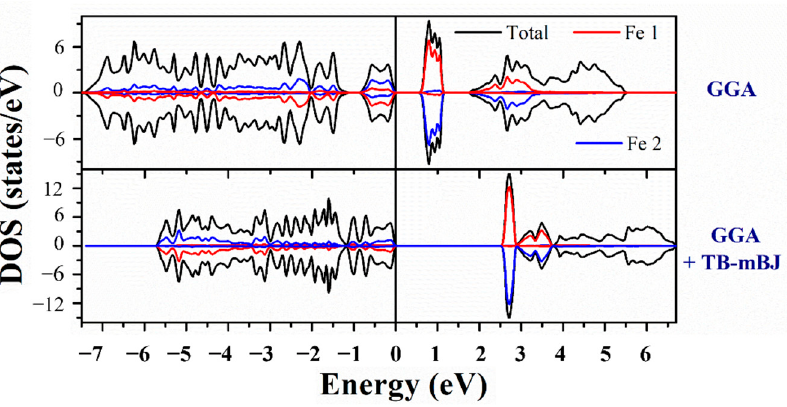
Figure 8. Density of electronic states of the bulk BiFeO 3 compound using three different approximations.